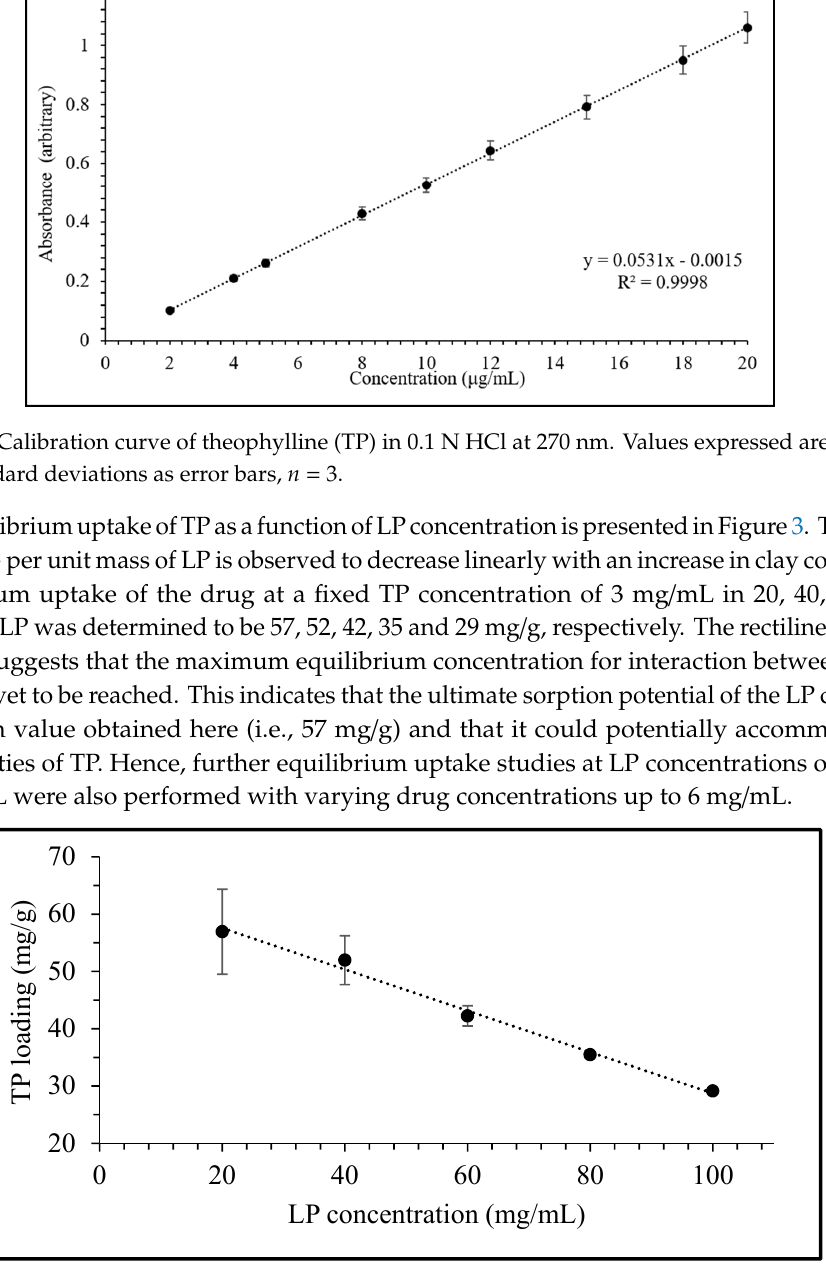
Figure 3. Equilibrium uptake of TP by Laponite® (LP) as a function of LP concentration. Values expressed are means with standard deviations as error bars, n = 3.